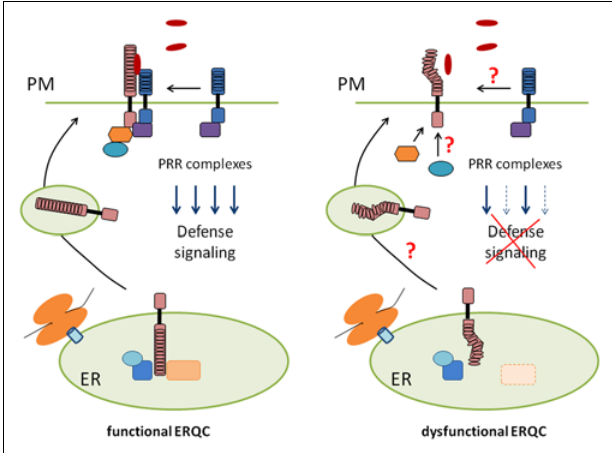
FIGURE 1 |A model for ER-mediated control of PRR biogenesis and signaling. In weakly dysfunctional alleles of ERQC components (right), folding defects of the extracellular domain of PRRs might affect stable accumulation at the plasma membrane (PM), subcellular trafficking, assembly of pre- and post-recognition complexes, or combinations thereof. Importantly, this can selectively impair a subset of diverse signaling outputs downstream of the